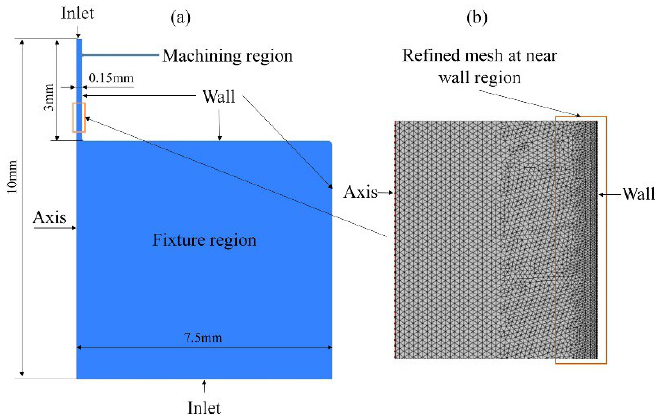
Figure 15. ( a ) The 2D axisymmetric geometry model of a micro hole and ( b ) the mesh distribution [131].